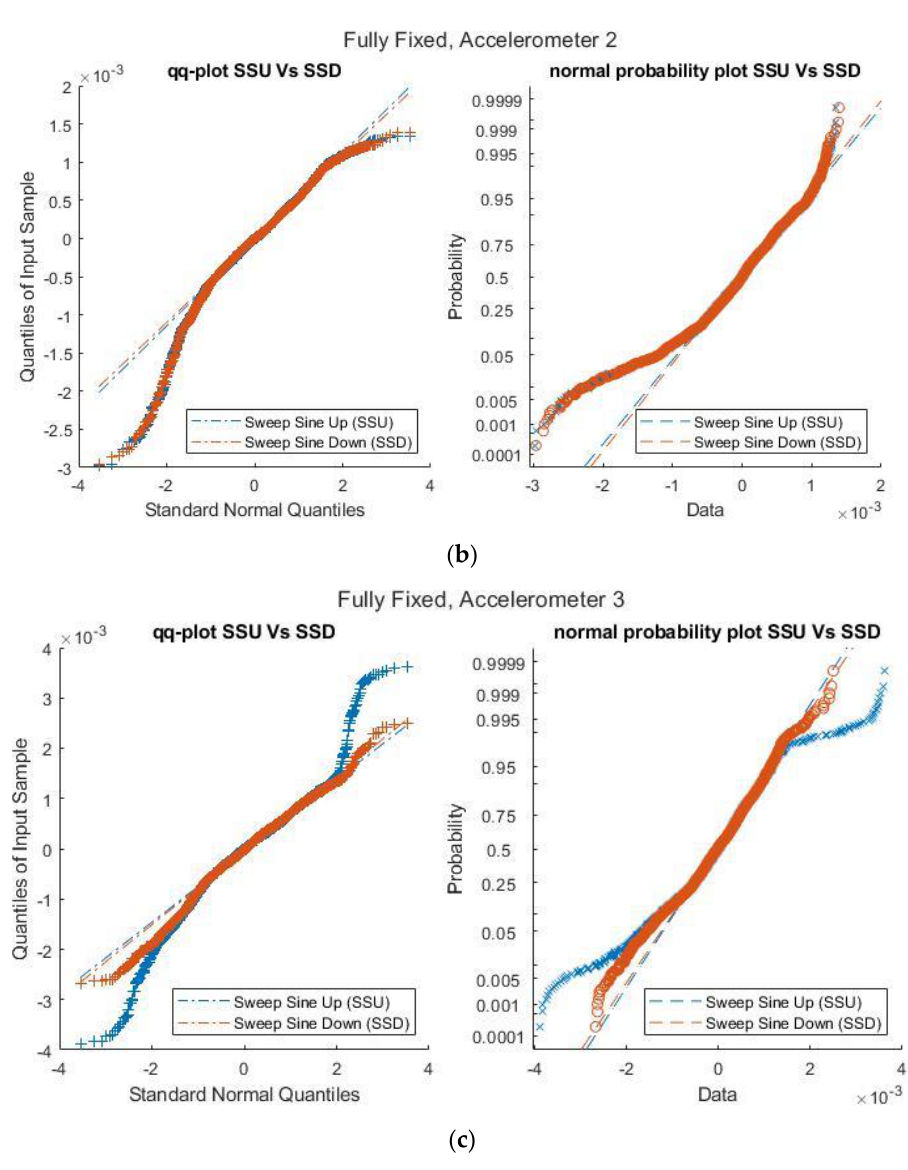
Figure 12. Q–Q and normal probability plots for SSU vs. SSD for accelerometers for ( a ) Accelerometer 1; ( b ) Accelerometer 2 and ( c ) Accelerometer 3. 1; ( b ) Accelerometer 2 and ( c ) Accelerometer